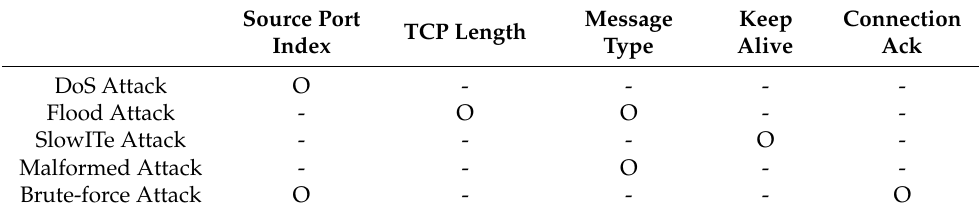
Table 2. Relation between MQTT attacks and